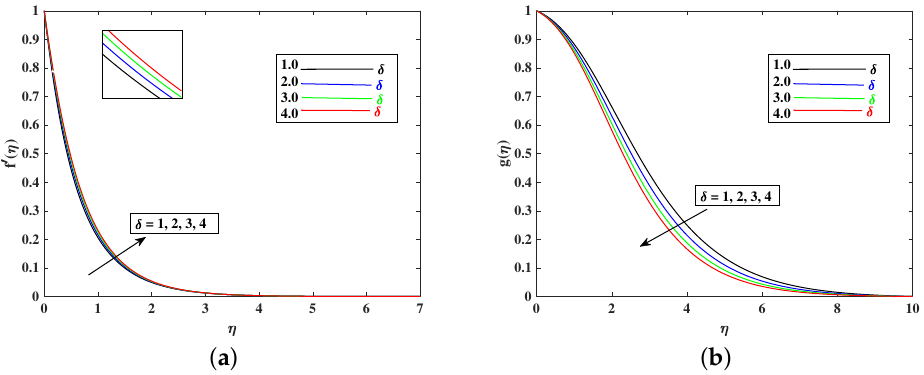
Figure 9. Variation of δ to influence the velocity and temperature field. ( a ) Variation of δ to influence the velocity. ( b ) Variation of δ to influence the